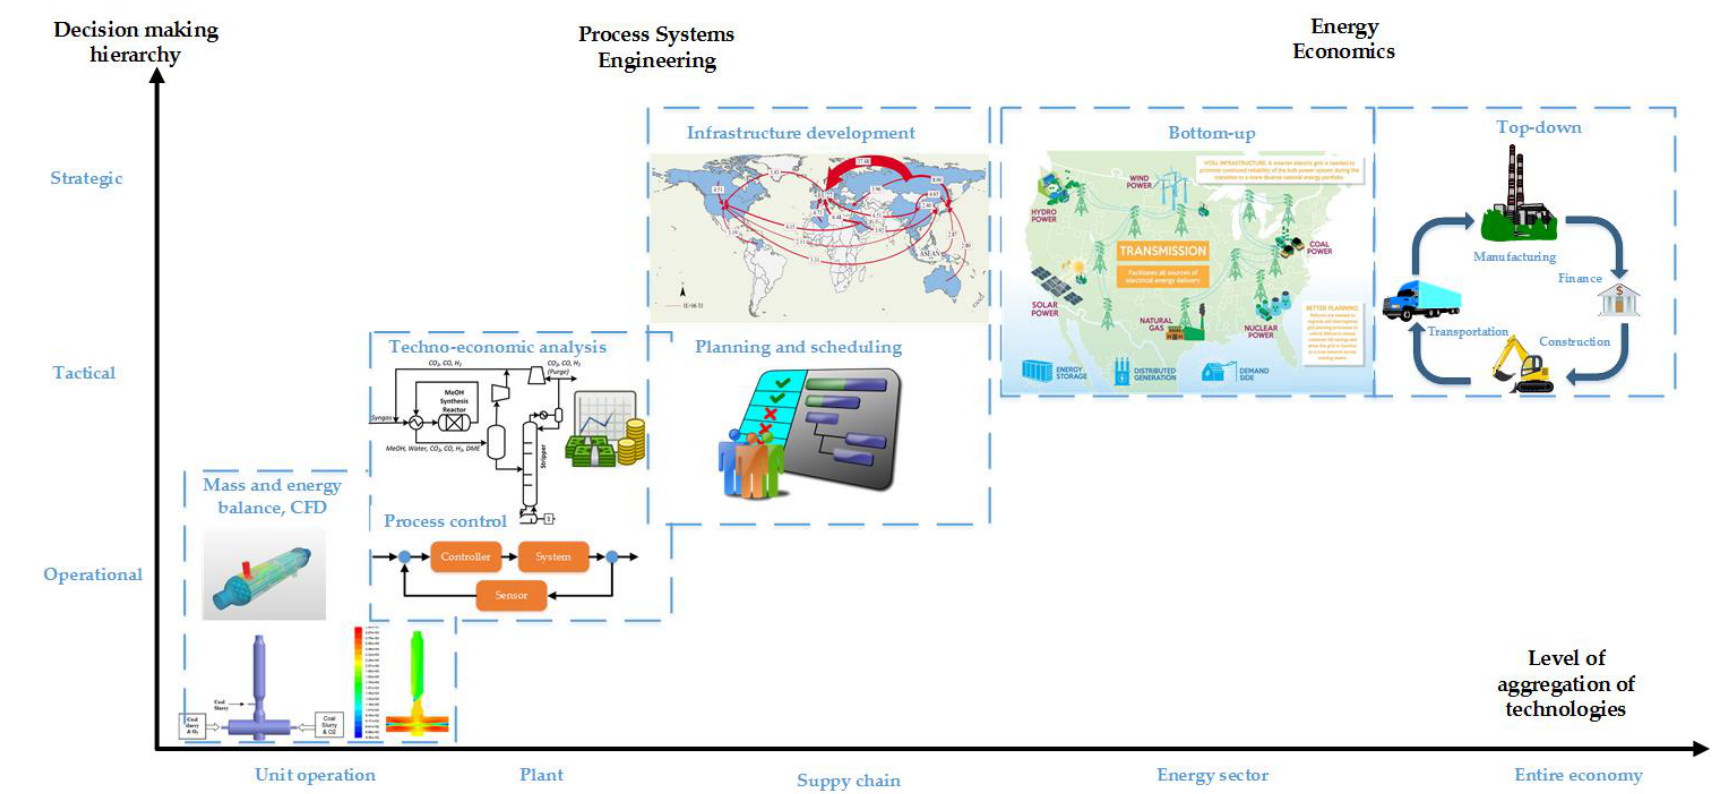
Figure 3. Classification of energy system models according to discipline and level of technological aggregation. Computational Fluid Dynamics (CFD) Gasifier model reprinted from [11] with permission from Elsevier, Process flow diagram reprinted from [12] with permission of Adams, Thato, Le Feuvre and Swartz Copyright (2018), global supply chain reprinted from [13] with permission from Elsevier.